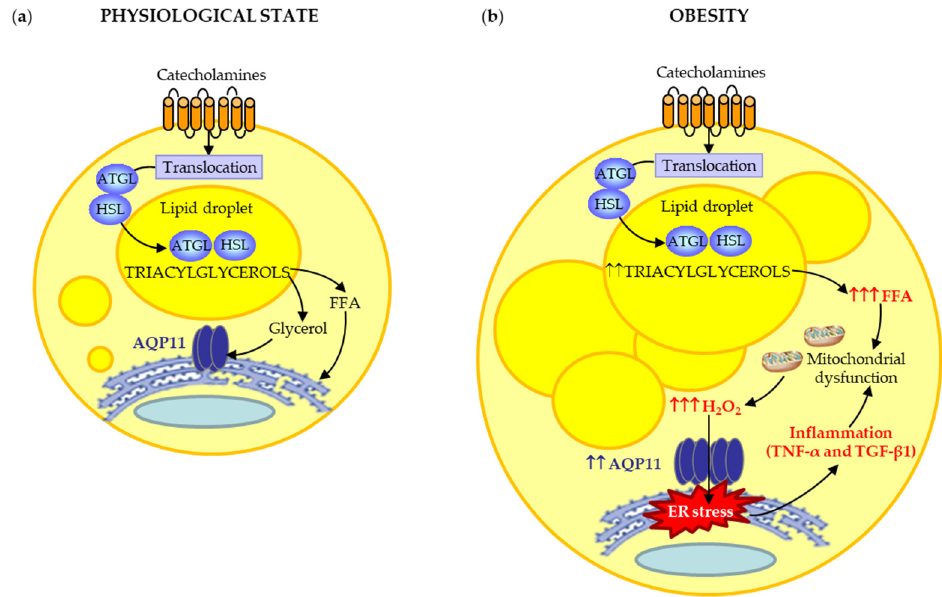
Figure 5. ( a ) Under physiological conditions, AQP11 contributes to glycerol mobilization for triacylglycerol synthesis in nascent lipid droplets in the ER. ( b ) In obesity, the peroxiporin activity of AQP11 appears to contribute to the alleviation of ER stress induced by the increased ROS production due to mitochondrial dysfunction under lipotoxic and inflammatory conditions. Although proinflammatory factors, such as TNF- α , TGF- β 1, or LPS downregulate AQP11, this superaquaporin is upregulated in obesity, suggesting that other factors are involved in AQP11 regulation in human adipocytes. ATGL, adipocyte triglyceride lipase; HSL, hormone-sensitive lipase.